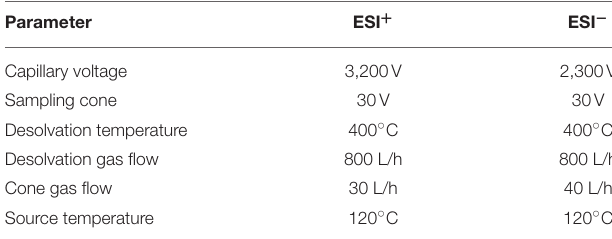
TABLE 2 | Analysis condition of positive and negative electrospray